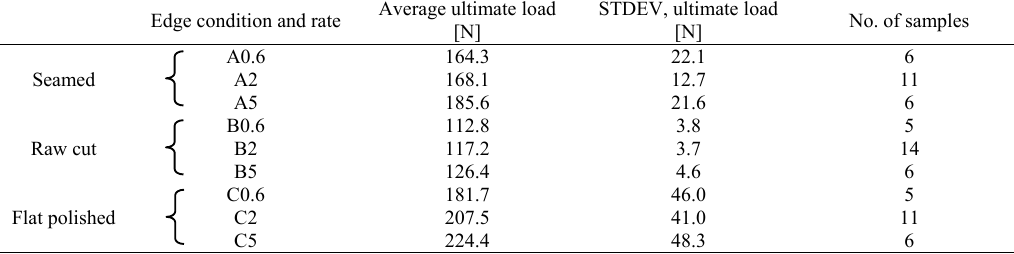
Table 1: Ultimate load and standard deviation for the different edge machining and loading